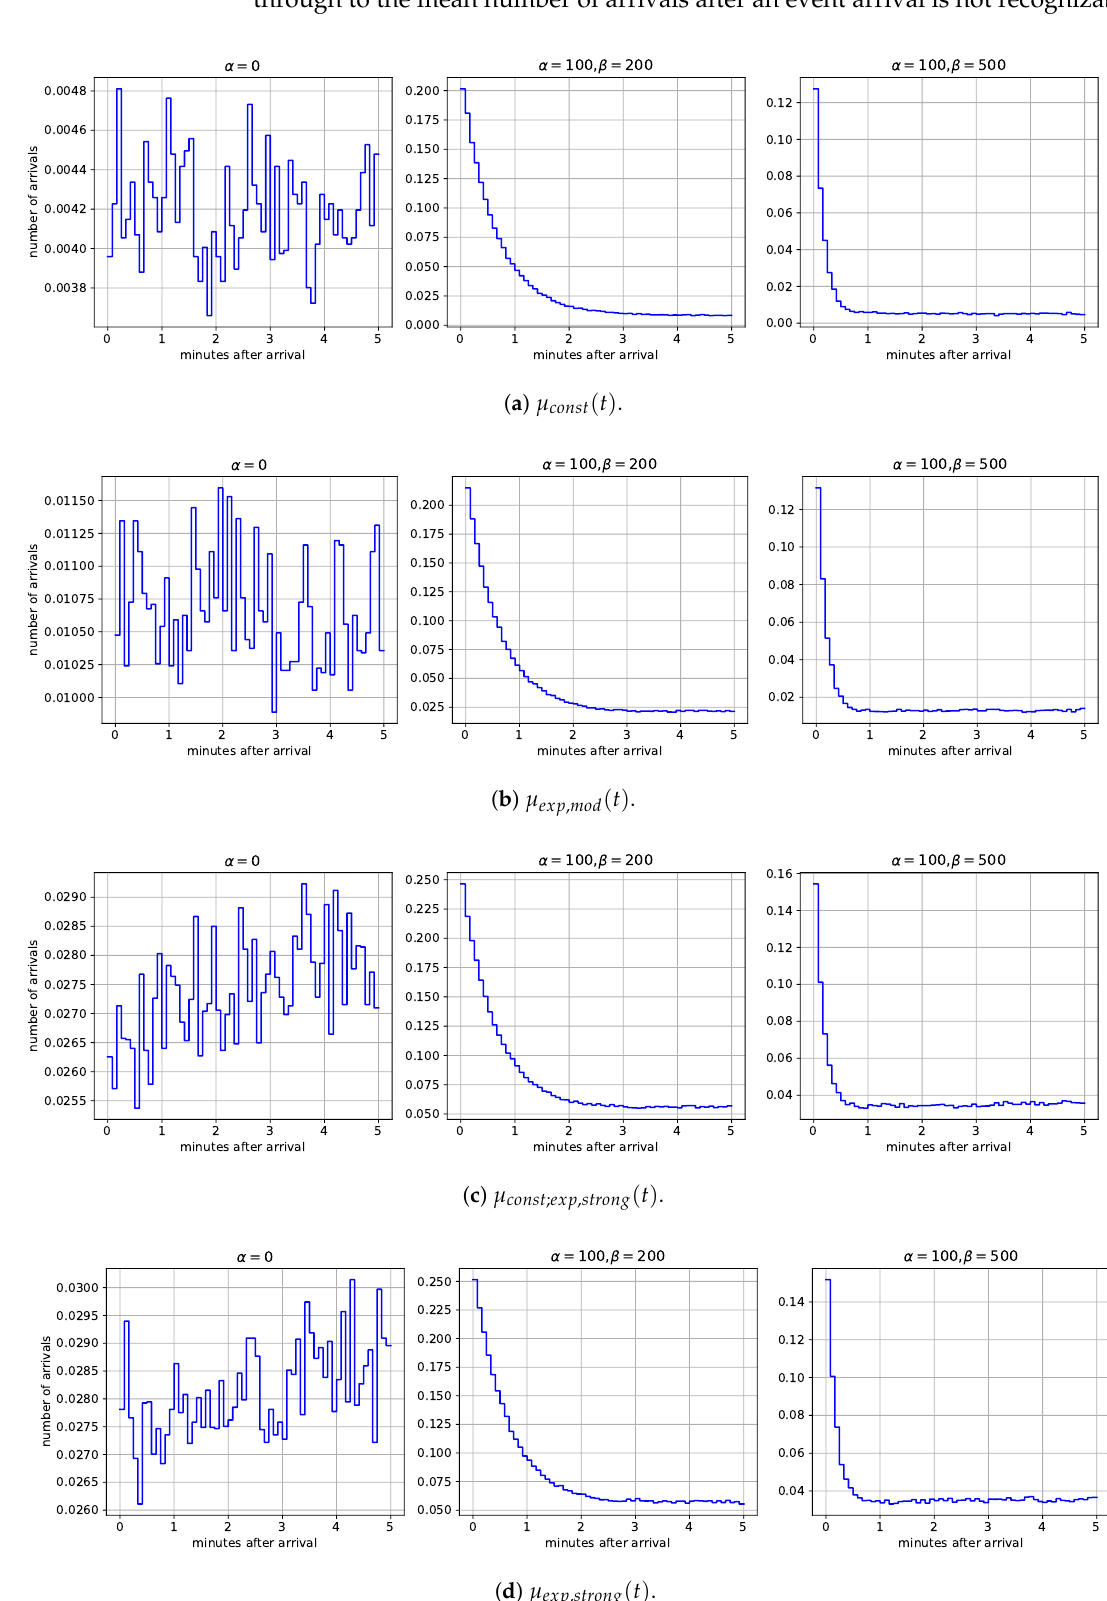
Figure A3. Mean number of event arrivals in time intervals of 5 s over 5 min after an event arrival. T = 21.25, N = 10 3